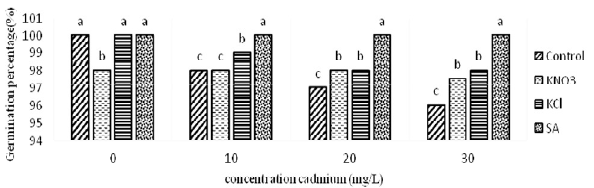
Fig. 1. Germination percentage of unprimed (UPS) and primed (PS) seedlings of fenugreek ( Trigonella foenum- graecum L.) under different Cd concentrations